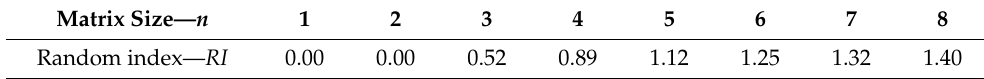
Table 4. Random inconsistency indexes ( RI ).